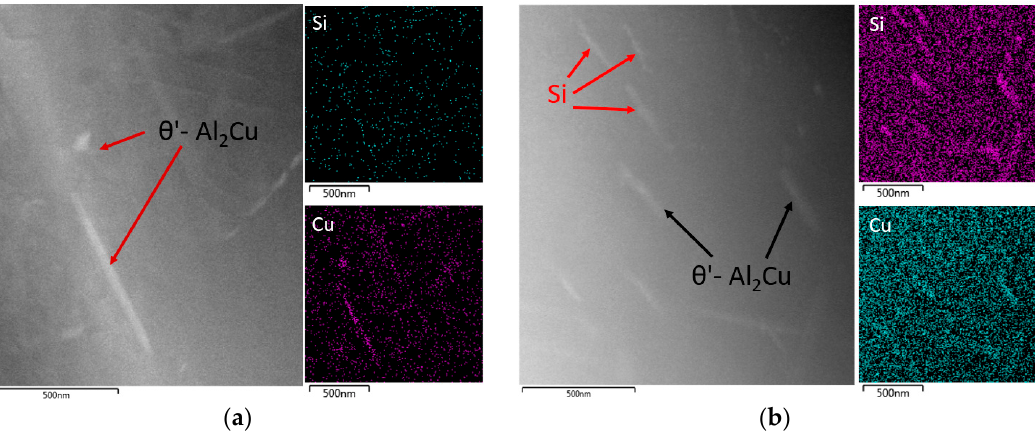
Figure 15. Substructure of 90–10 alloy after artificial aging, TEM; ( a ) Overview ( b ) Detailed view ( c ) High resolution.